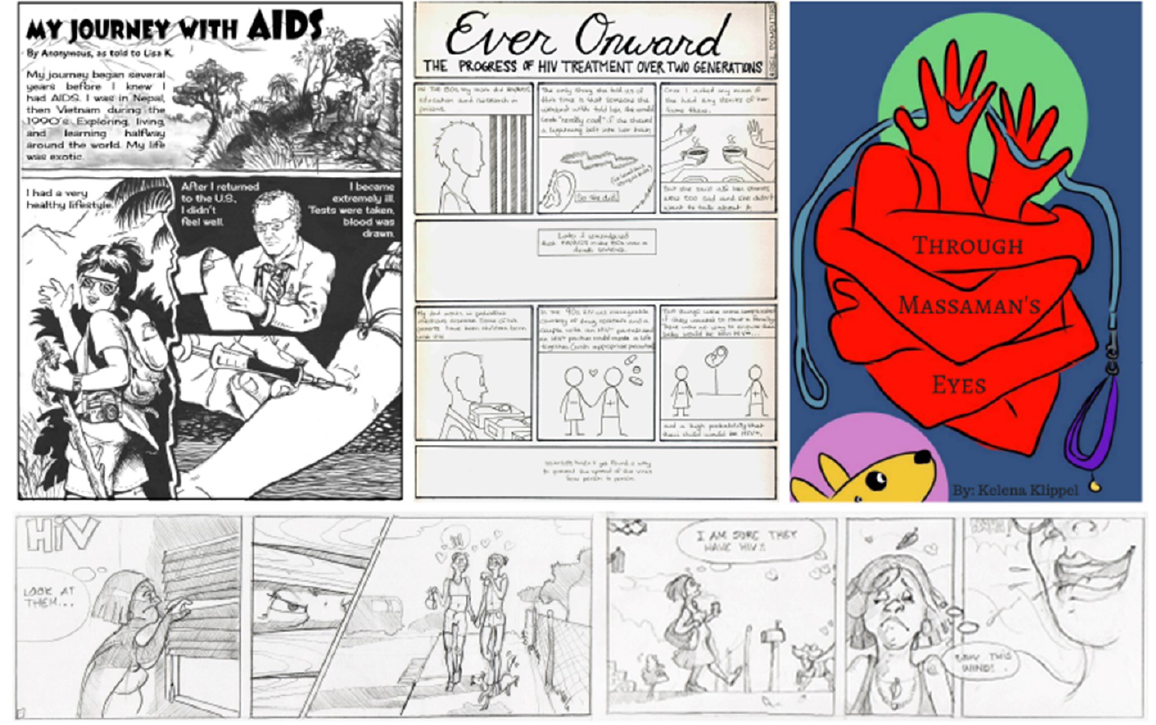
Figure 1 The four submissions to the HIV/AIDS Graphic Novel